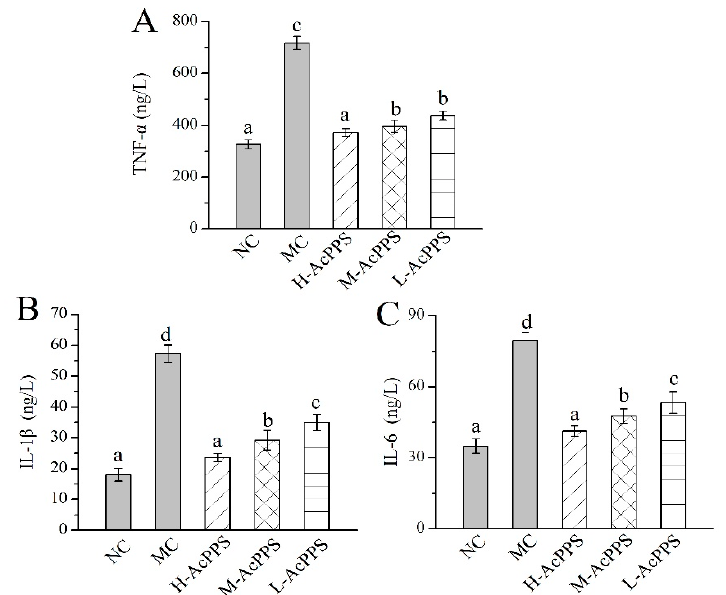
Figure 5. E ff ects of AcPPS on inflammatory cytokines of bronchoalveolar lavage fluid (BALF) in ALI mice. ( A ) TNF- α , ( B ) IL-1 β , and ( C ) IL-6. The values were reported as the Mean ± S.D. ( n = 10 for each group). Means with the same letter are not significantly di ff erent ( p <